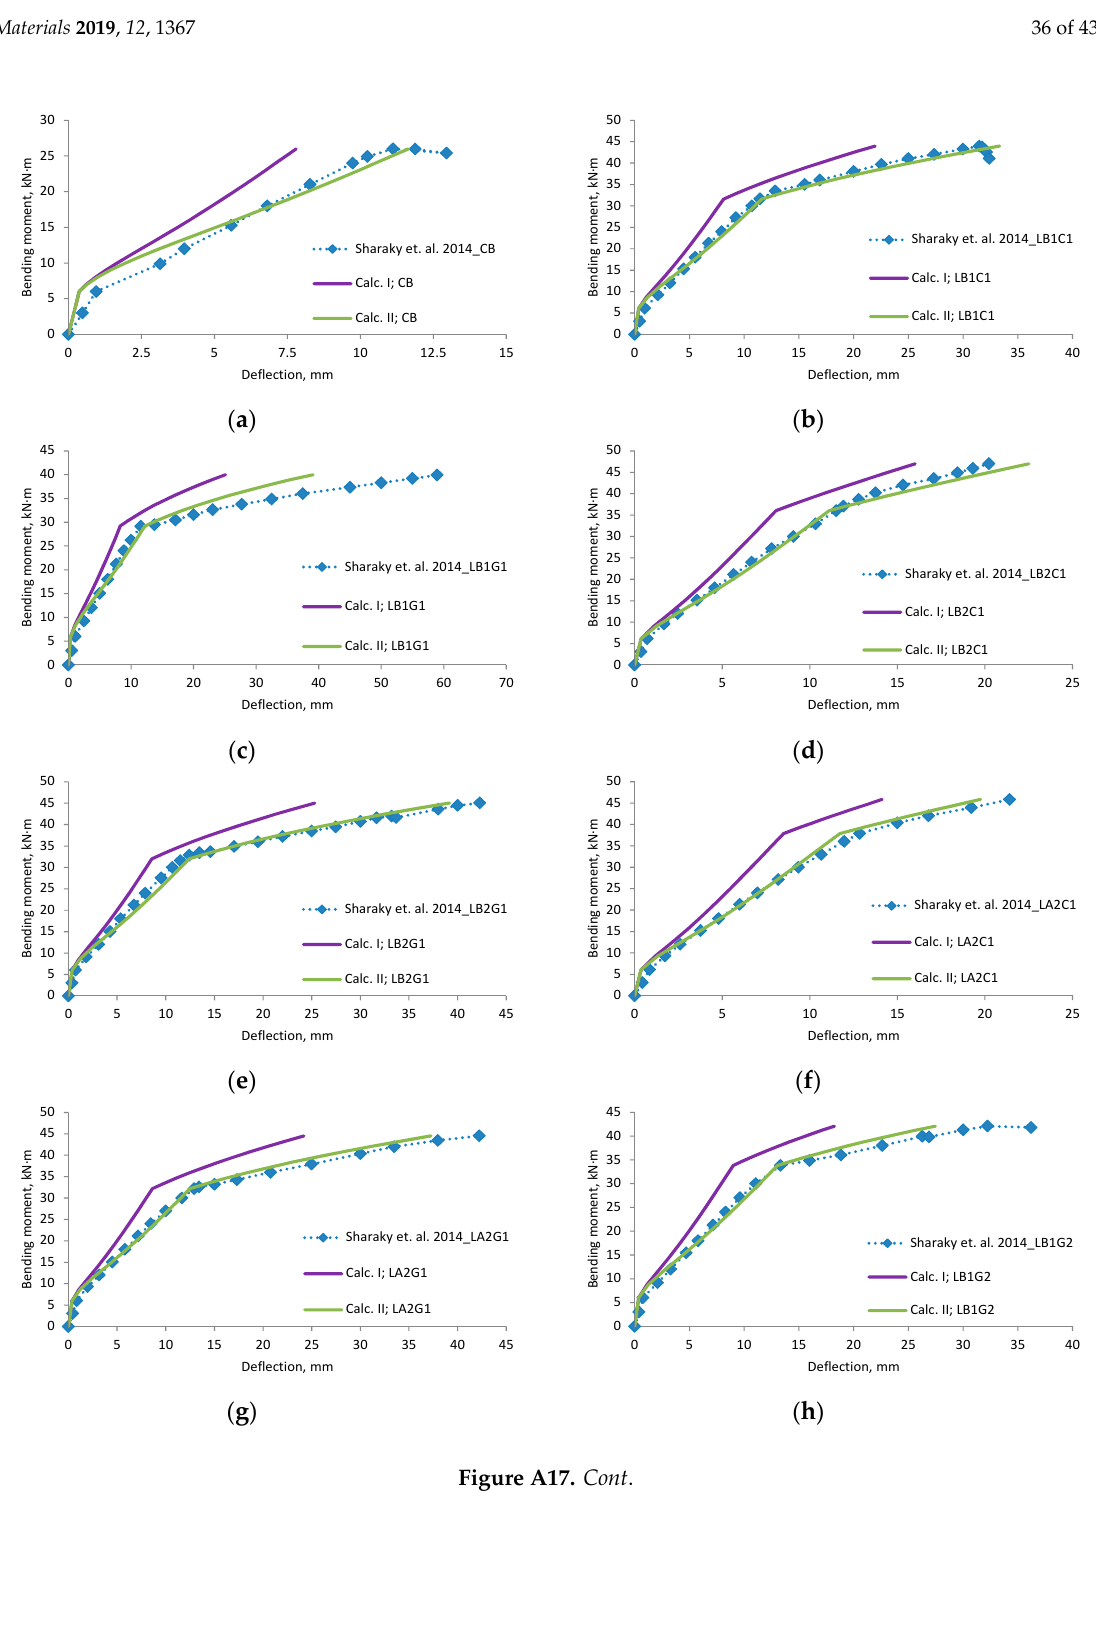
Figure A16. Rezazadeh et al., 2014 [39] research beams deflection compared with calculated, ( a ) beam Control; ( b ) beam Non prestressed; ( c ) beam 20% prestressed; ( d ) beam 30% prestressed; e ) beam 40% prestressed; ( f ) scatter of the results at 60% and 80% of the ultimate load.